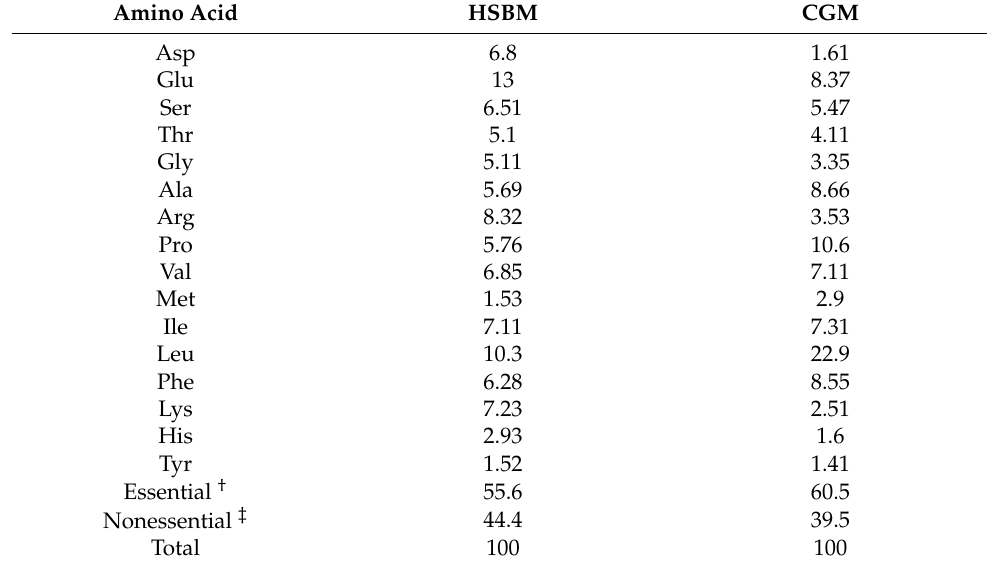
Table 2. Amino acid composition (g/100g of total AA measured) of heated soyabean meal (HSBM) and corn gluten meal